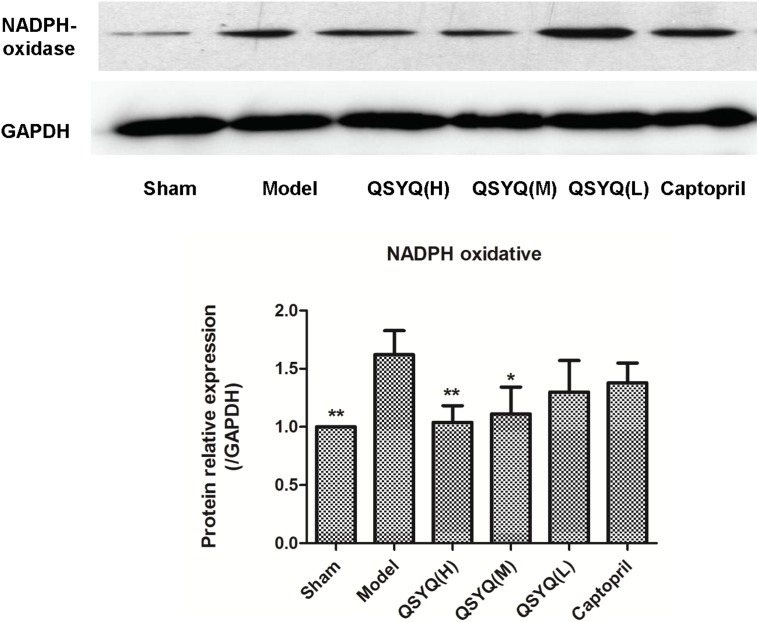
QSYQ treatment significantly decreased cardiac NADPHoxidase in rats with HF.The NADPHoxidase in model group was increased compared with sham group, while treated by QSYQ (H) and (M) doses, the levels showed 35.80% and 31.48% reduction, respectively. The treatment with QSYQ in low-dosage and captopril didn’t improve the NADPHoxidase significantly. The effect of QSYQ on NADPHoxidase showed a dosage-dependent manner. n = 10∼14 for each group. Data were analyzed by one-way ANOVA, with p<0.05 indicating statistical significance. *Differed significantly from the model group (p<0.05).